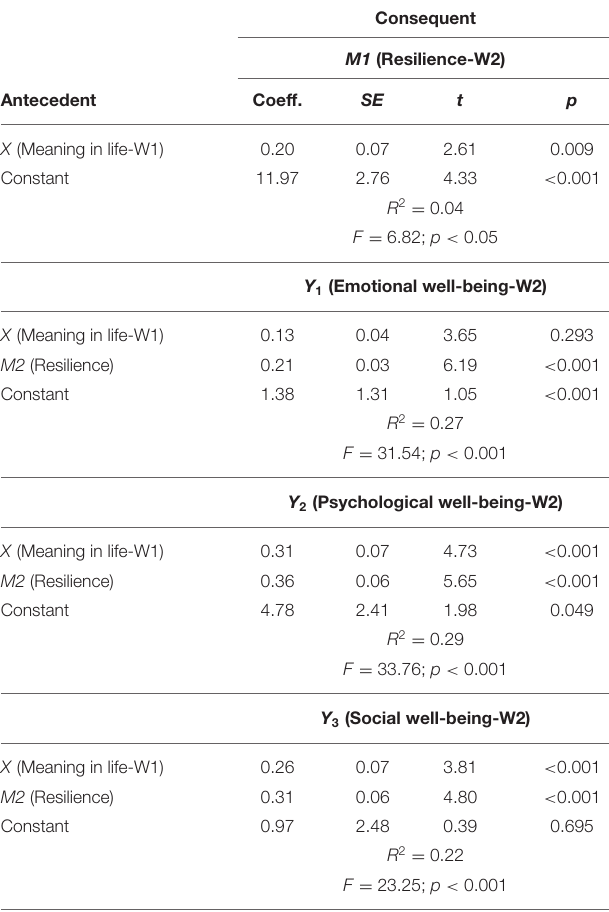
TABLE 2 | Unstandardized coefficients for the mediation